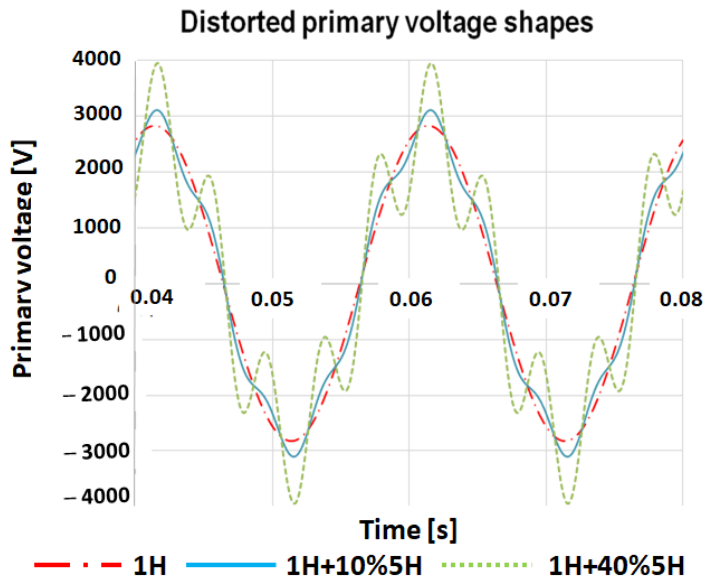
Figure 7. The curve of the distorted primary voltage (where the first harmonic of 50 Hz amplitude is 100%—2000 V, fifth of 250 Hz harmonic of 10%—200 V or 40%—800 V rated amplitude), and (total harmonic distortion ( THD ) = 0.1 and 0.4). Abbreviation 1H means the first harmonic with amplitude of 100% of the rated